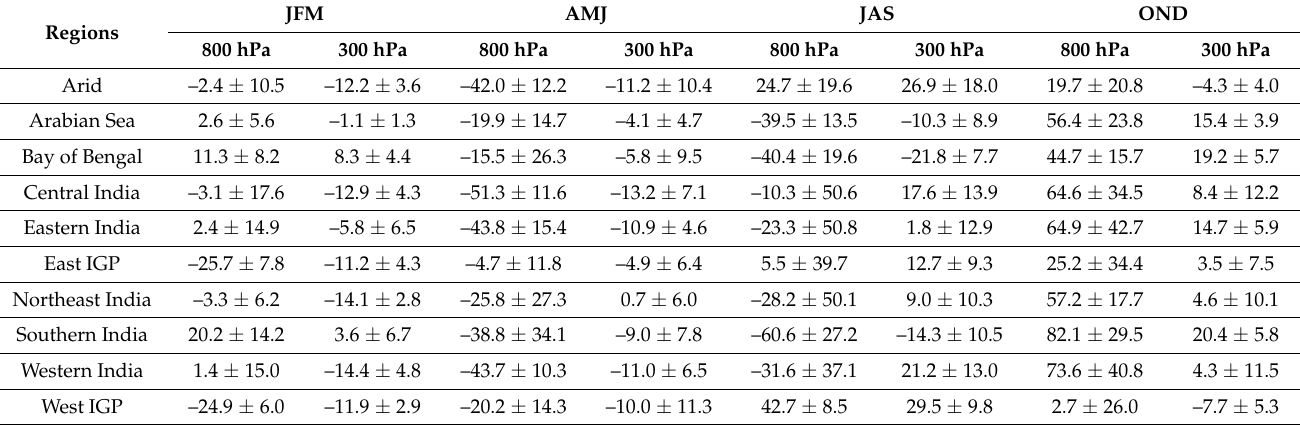
Table 1. Mean and 1- σ SD uncertainty of multi-year (2009–2014) seasonal variation of CH 4 at the levels of 800 and 300 hPa for JFM, AMJ, JAS, and OND derived from GOSAT-TIR by the Prophet model as shown in Figure 11.